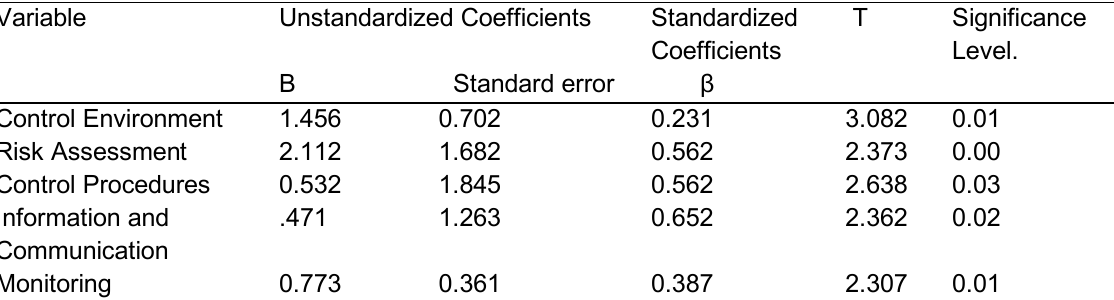
Table 4: Internal Control and